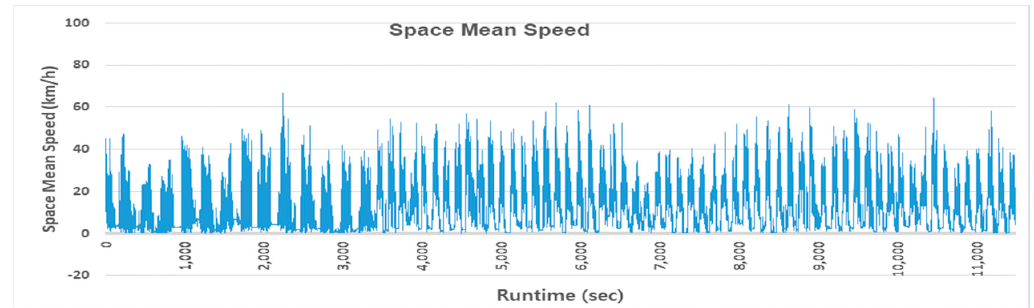
Figure 14. Profile of the space mean speed for the testbed.